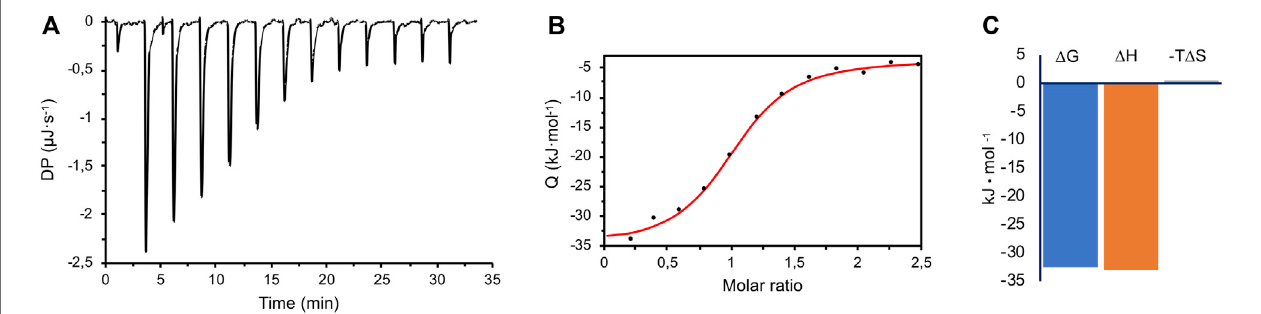
FIGURE 6 | ITC measurements. (A) A representative raw titration data (black thermogram) obtained from the titration of 30 μ M CK2 α with 400 μ M Ru 4 POM at 25.3 ° C, in 25 mM Tris, 500 mM NaCl, pH 8.5. (B) Wiseman plot of integrated data (black circles) and fi tted isothermal binding curve (in red). From two independent experiments, an apparent mean K D of 2.09 ± 0.36 μ M for the single macroscopic dissociation constant was obtained, with a 1:1 stoichiometry. (C) The mean Δ G of the overall binding is dominated by the enthalpic term ( Δ H), with a negligible entropic contribution ( ‒ T Δ